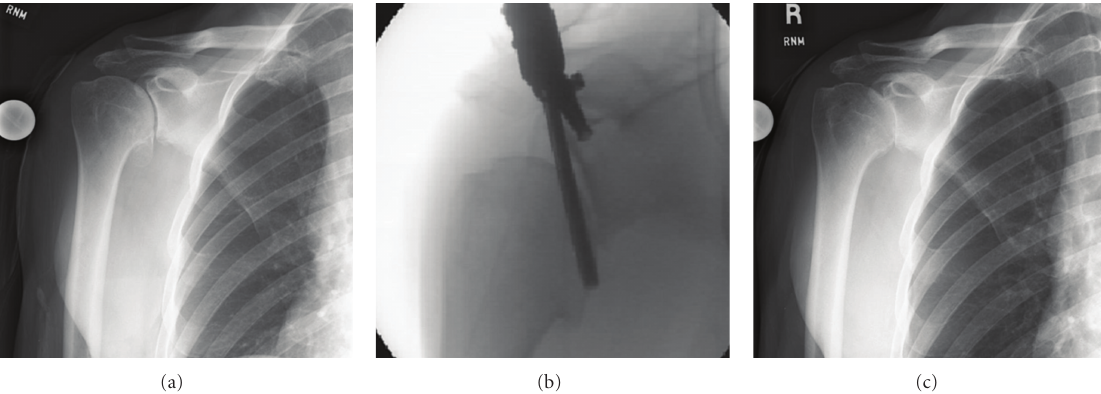
Figure 3: Preoperative (a) Intraoperative (b), and postoperative (c) radiologic imaging of the Comprehensive Arthroscopic Management procedure of an osteoarthritic shoulder of a 52-year-old male. (b) shows the osteoplasty of the inferior humeral osteophyte with the arthroscopic